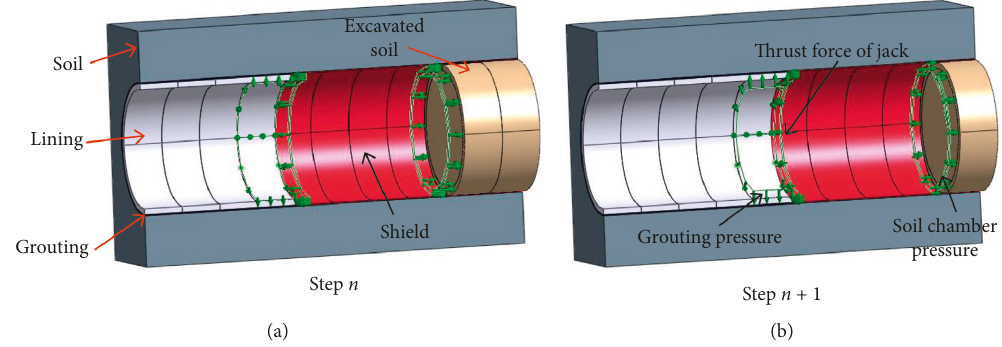
Figure 7: Finite element simulation of shield tunneling.